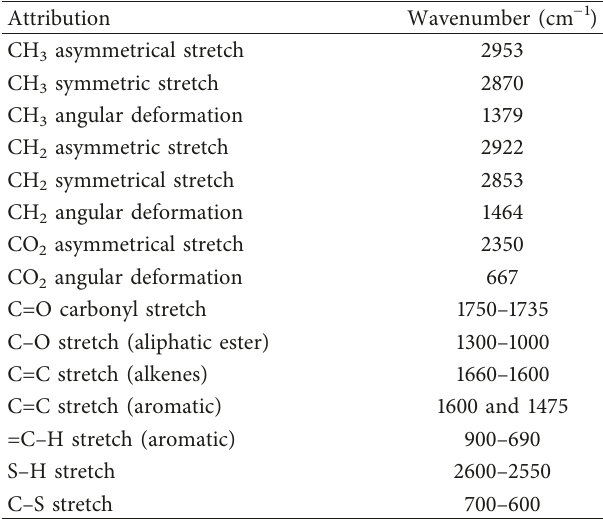
Figure 1: Infrared spectra of all diesel samples. Table 3: Infrared vibrational groups of the diesel samples [42,